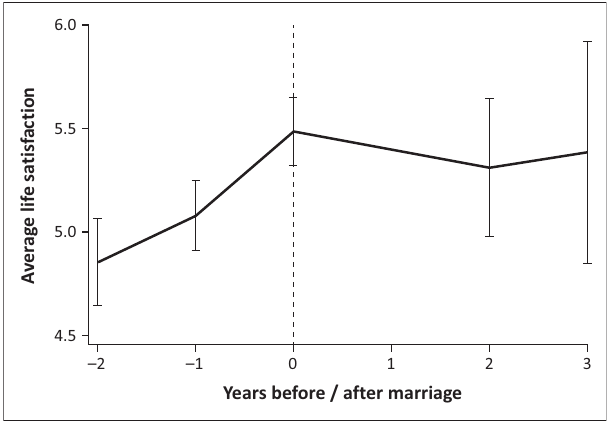
FIGURE 1: Subjective well-being before and after year of marriage for males, 2008–2017.